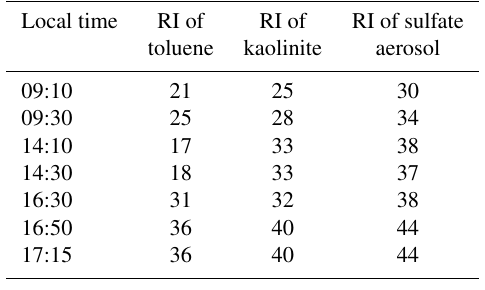
Table 4. Modelled lidar S ratios (sr) for selected periods on 23 Au- gust using refractive indices (RIs) of different particles.